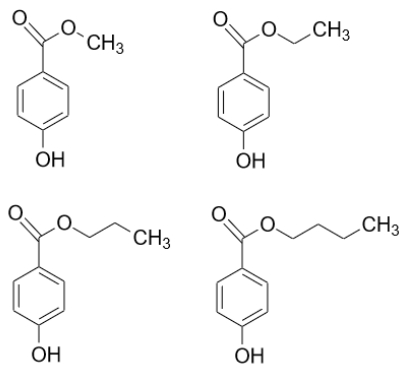
Figure 1. Chemical structure of the most commonly used parabens in growing alkyl chain length: methyl paraben, ethyl paraben, propyl paraben, butyl paraben.